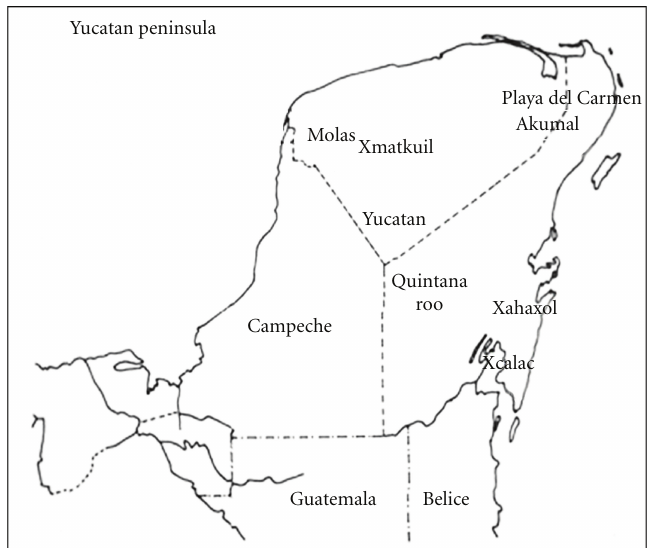
Figure 1: Map of the Yucatan Peninsula, Mexico, showing the geographical location of Molas and Xmatkuil in Yucatan State and Playa del Carmen, Akumal, Xcalac and Xahuachol in Quintana Roo